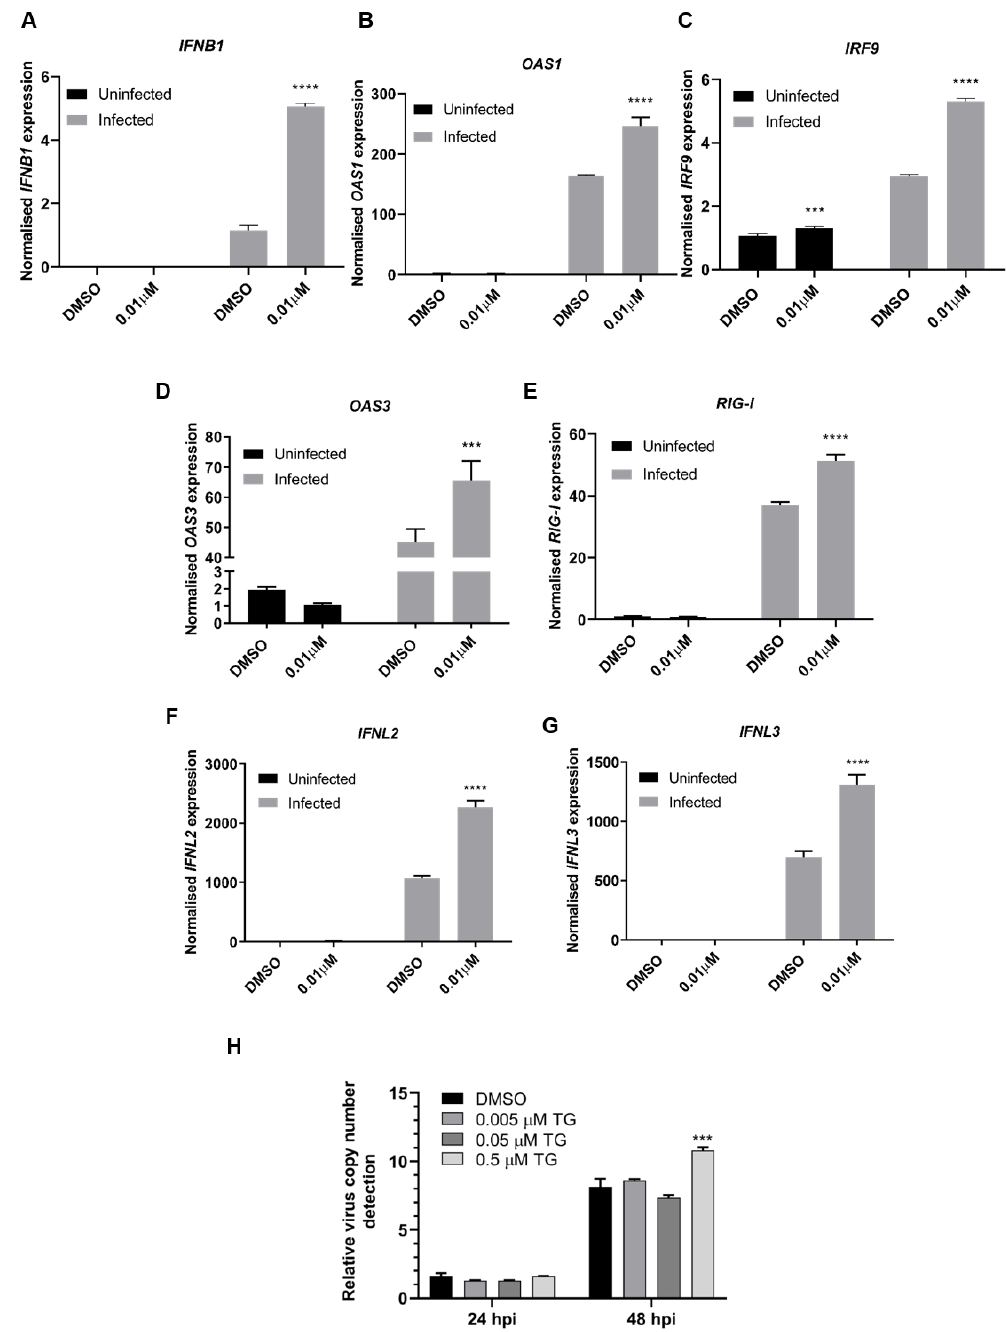
Figure 8. TG priming enhanced type I / III IFN-dependent gene expression. ( A – G ) NHBE cells were incubated for 30 min with DMSO or 0.01 µ M TG and subsequently infected with USSR H1N1 virus at 0.5 MOI for 24 h. Total RNA was extracted from each sample for type I / III IFN and indicated associated gene expression, normalised to 18S rRNA. Significance determined by two-way ANOVA, relative to corresponding DMSO control. ( H ) Vero cells were primed with TG as indicated for 30 min, washed twice with PBS and infected with USSR virus 0.5 MOI. Viral RNA extraction was performed on culture media at 24 and 48 hpi followed by one-step reverse transcription qPCR to detect the relative copy number of M-gene RNA, based on relative Ct method. Vero cells are unable to produce type I IFNs, which appear necessary for TG to induce an antiviral state. Indicated significance based 2-way RM ANOVA relative to corresponding DMSO control. *** p < 0.001, **** p <